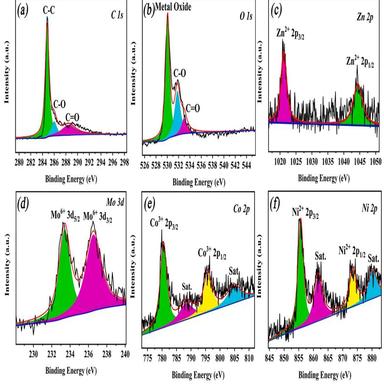
XPS spectrum of ZnCo2O4@NiMoO4/CP: (a) C; (b) O; (c) Zn; (d) Mo; (e) Co; (f) Ni.